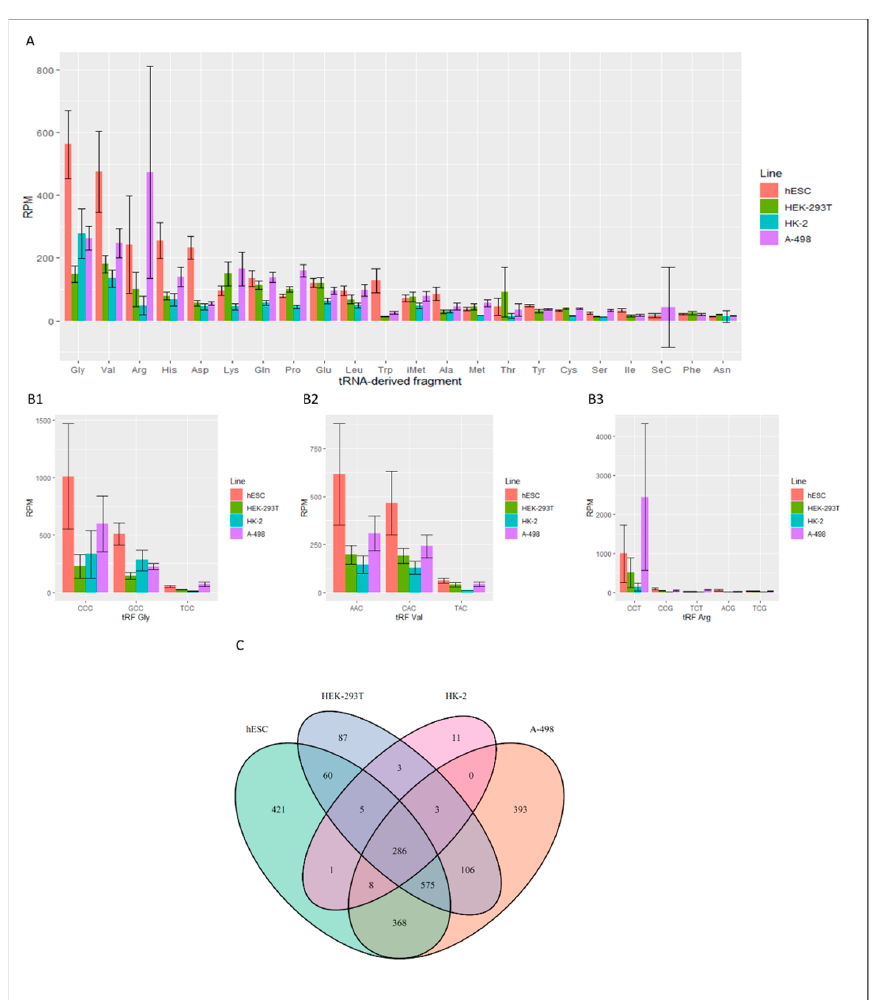
Figure 2. Bioinformatic characterization of tRNA-derived fragments in renal cells. ( A ) tRF occurrence in different renal cells. ( B1 – B3 ) Analysis of the most abundant tRFGly, tRFVal and tRFArg isoacceptors. ( C ) Venn diagram formed using the number of specifically expressed tRFs and their presence in different cells.